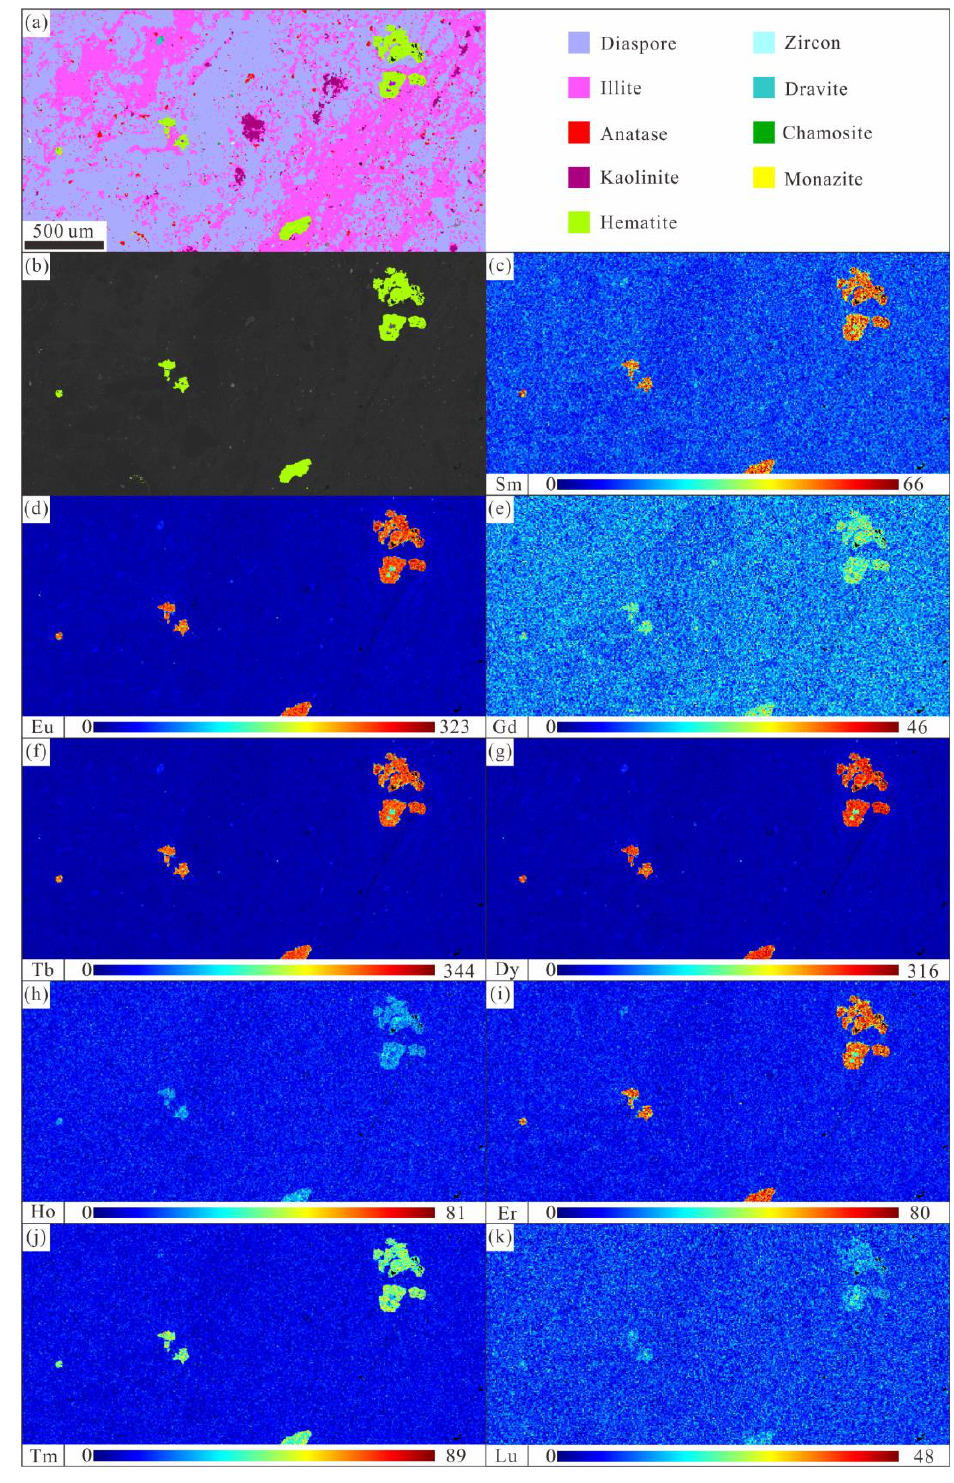
Figure 12. TIMA mineral and REE scanning maps of the representative Lindai bauxite ores. ( a ) All minerals; ( b ) hematite; ( c ) Sm element; ( d ) Eu element; ( e ) Gd element; ( f ) Tb element; ( g ) Dy element; ( h ) Ho element; ( i ) Er element; ( j ) Tm element; ( k ) Lu element.